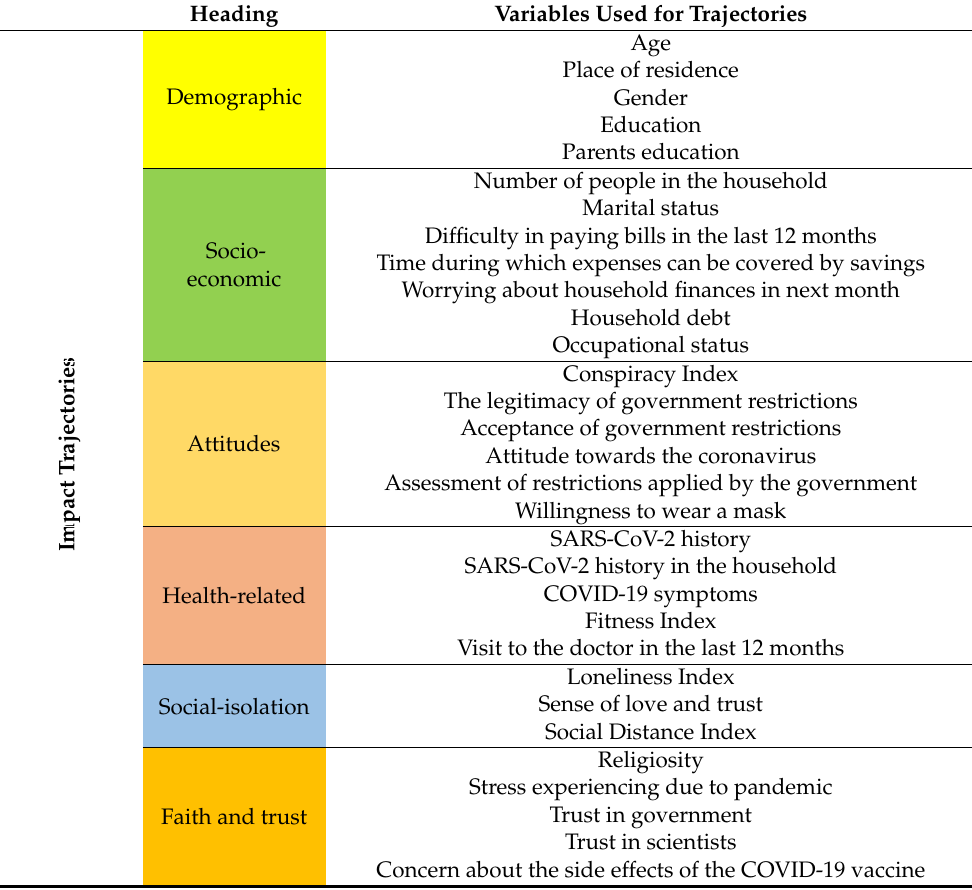
Table 3. Trajectories and variables use for the logistic regression models.